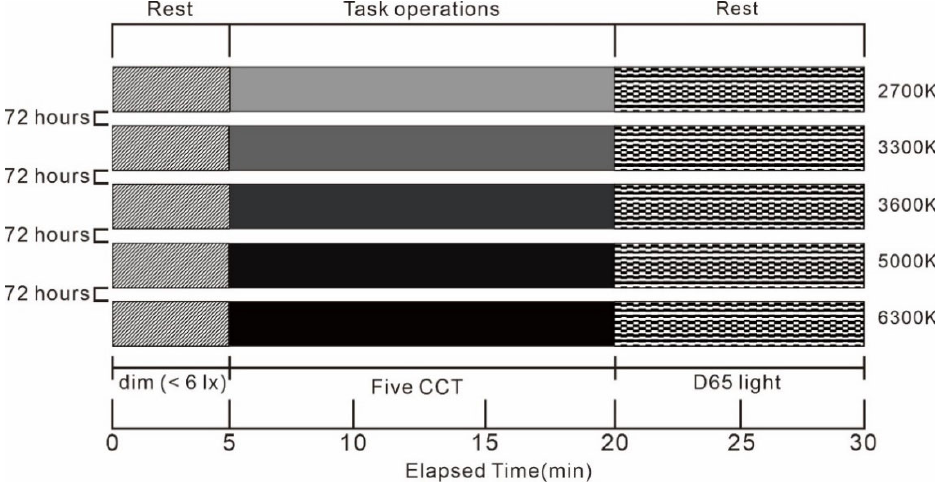
Figure 3. Experimental designs .